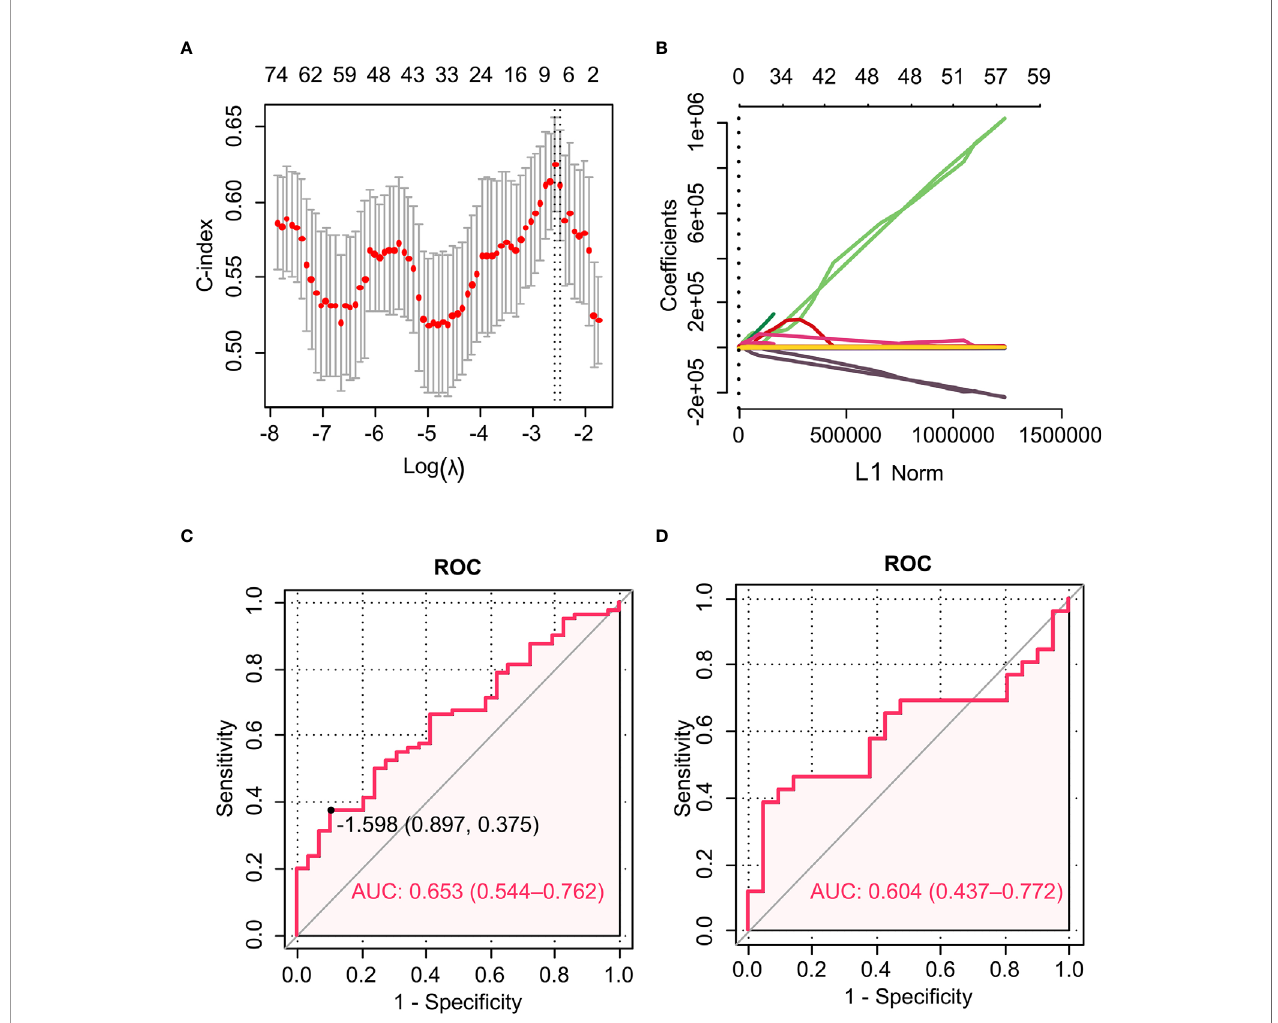
FIGURE 2 | The LASSO algorithm and 10-fold cross-validation were applied to extract the optimal subset of radiomic features. ROC curves for the radiomic model in predicting RFS. (A) The AUC reached the peak corresponding to the optimal number of radiomic features when the ln ( l ) value increased to 0.0925. Optimal features were determined by the AUC value. (B) LASSO coef fi cient pro fi les of the 94 radiomic features. The vertical line was drawn at the value determined by 10-fold cross-validation, where the optimal l generated six non-zero coef fi cients. (C) ROC curve of the training cohort. (D) ROC curve of the validation